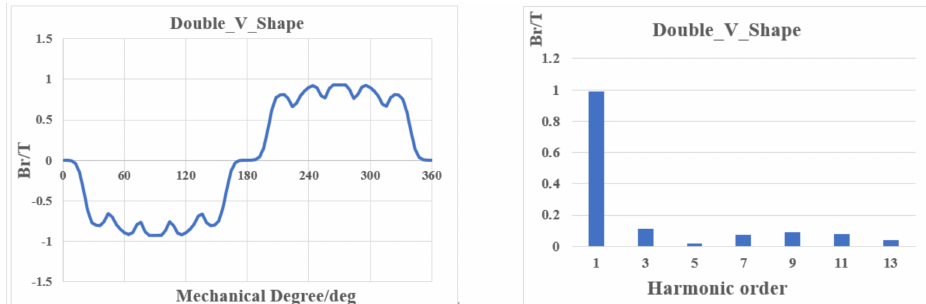
Figure 4. Br and its FFT of double V-shaped